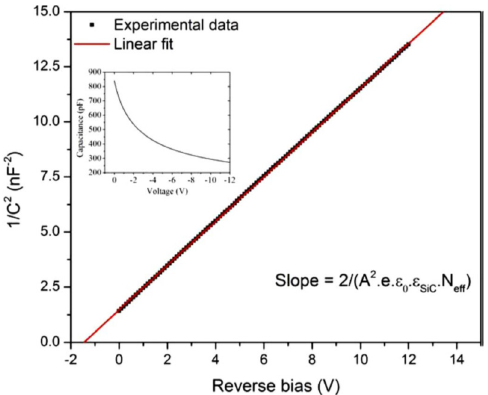
Figure 5. Plot of 1/C 2 as a function of reverse bias voltage recorded at room temperature for a 50 µm n-type Ni/4H-SiC (n-S50) SBD. The original C-V plot is shown in the